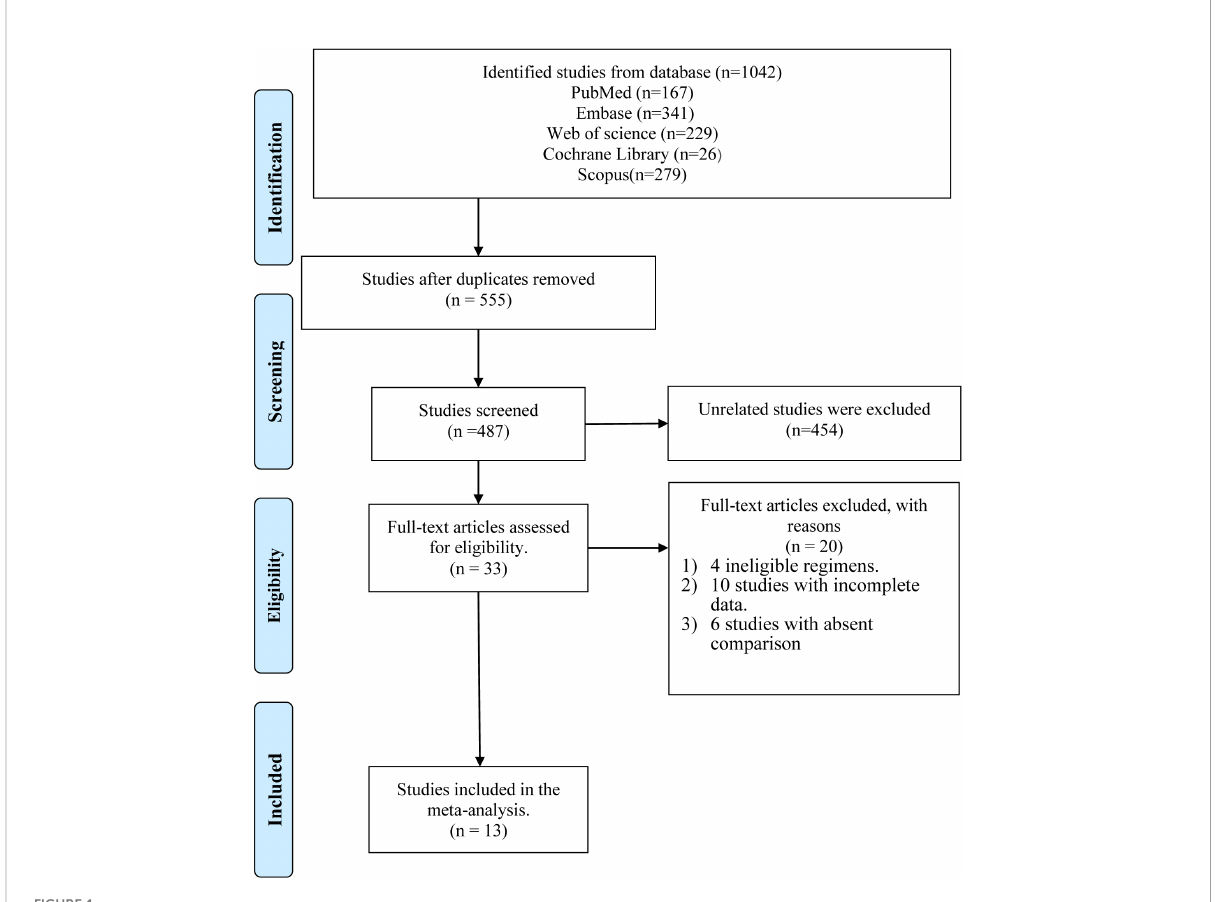
FIGURE 1 Results of literature